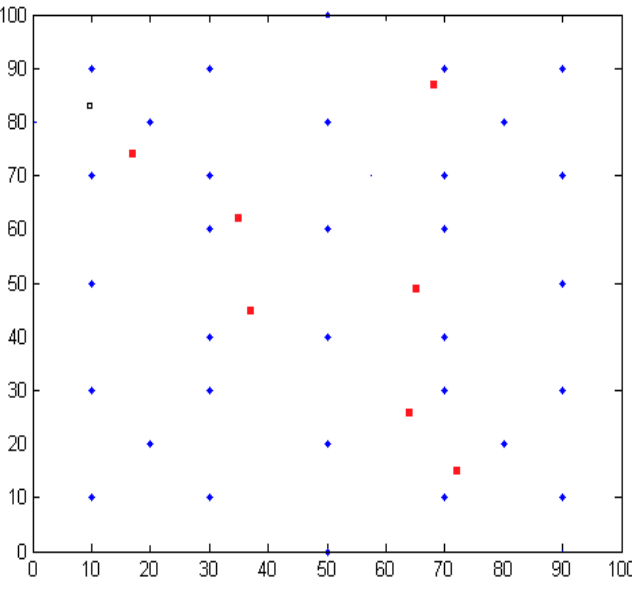
20 of 27 Figure 18. Comparing location algorithm error.